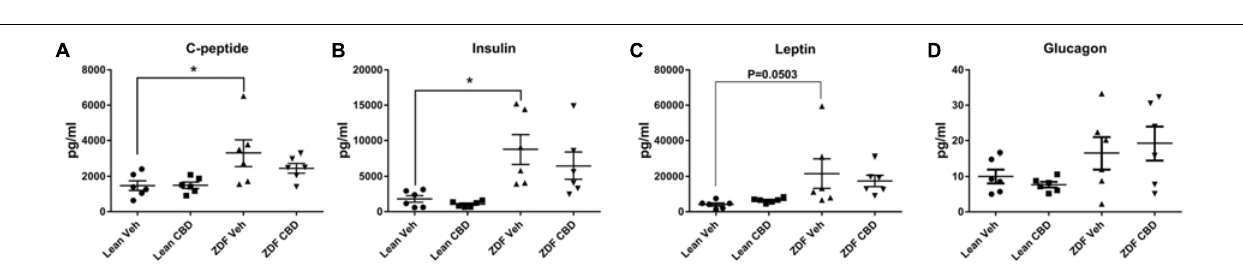
FIGURE 5 | Circulating metabolic hormones in serum samples from ZDF Lean (circles and squares) and ZDF rats (triangles) that were treated with either vehicle (circles and upward triangles) or 10 mg/kg CBD (i.p., 7 days; squares and downward triangles). Data are mean ± SEM, with n = 6 animals per group. ∗ P <